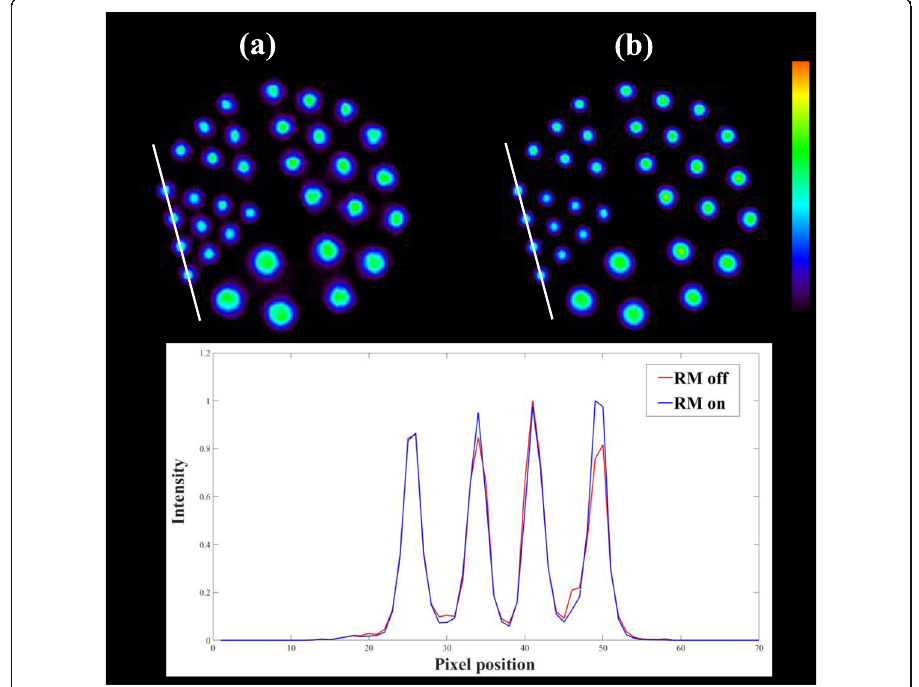
Fig. 7 Images of the Derenzo phantom scanned parallel to the z direction with RM off ( a ) and RM on ( b ) from DP-PET scan. The bottom also shows the profiles through the hot rods, as shown by the white lines in the